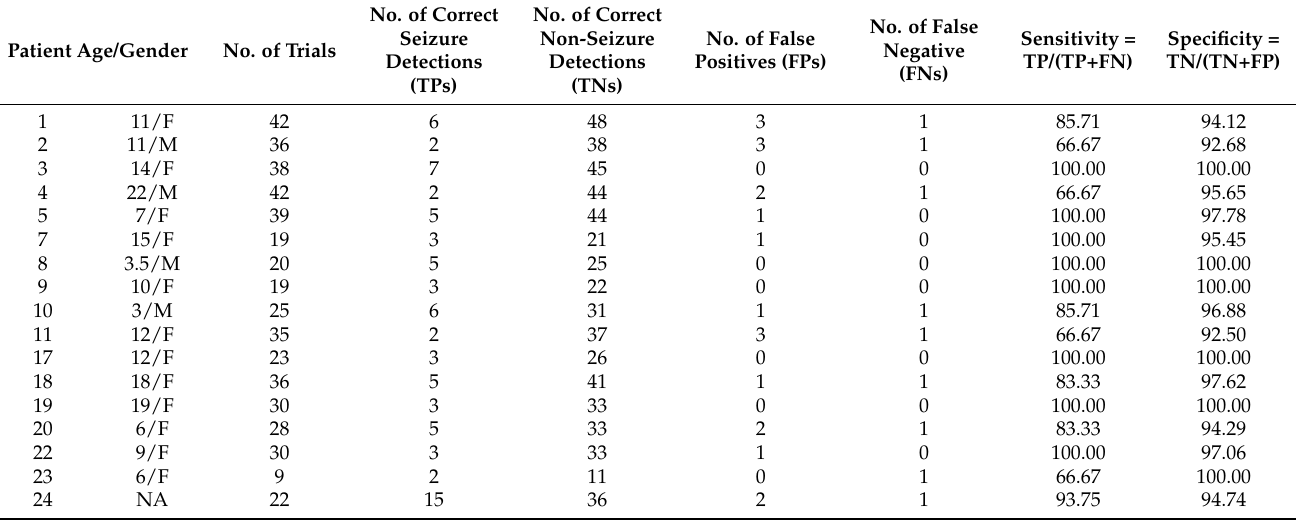
Table 5. Automatic test results for selected